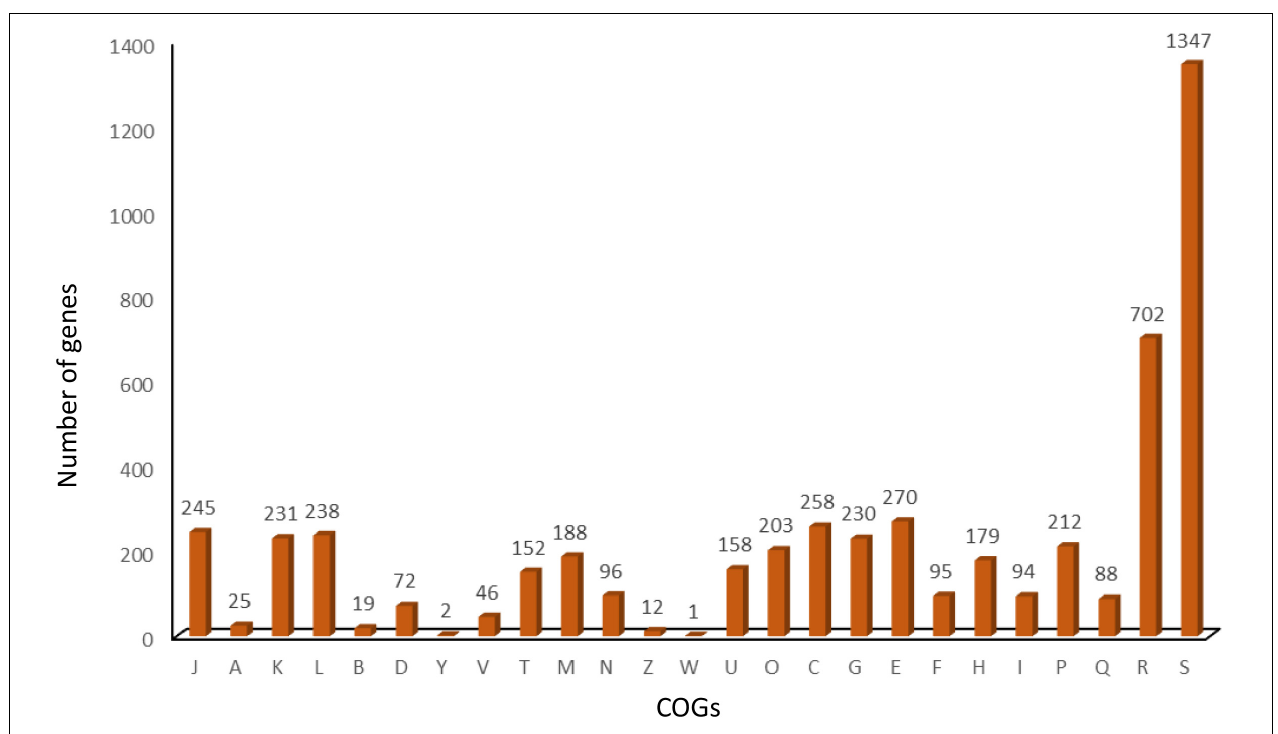
FIGURE 5 | COG-based functional categories of core genome of the analyzed Brucella melitensis